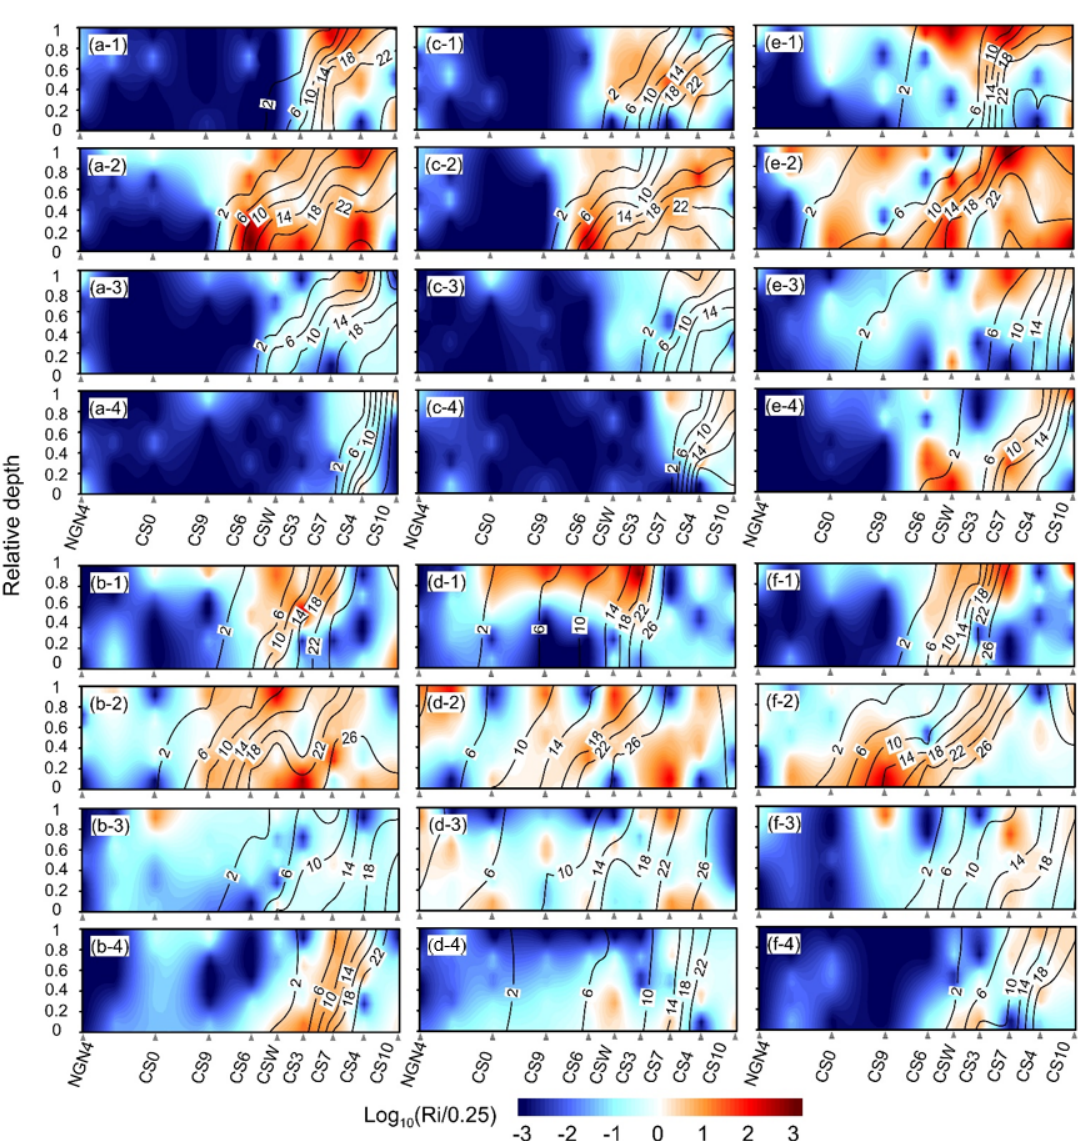
Figure 5. Variations of salinity and stratification along the DNC: The ( a – f ) represent six observations, respectively (according to Figure 2). ( 1 – 4 ) represent peak flood, high water slack, peak ebb and low water slack, respectively. The isohalines (in psu) are shown in black lines.